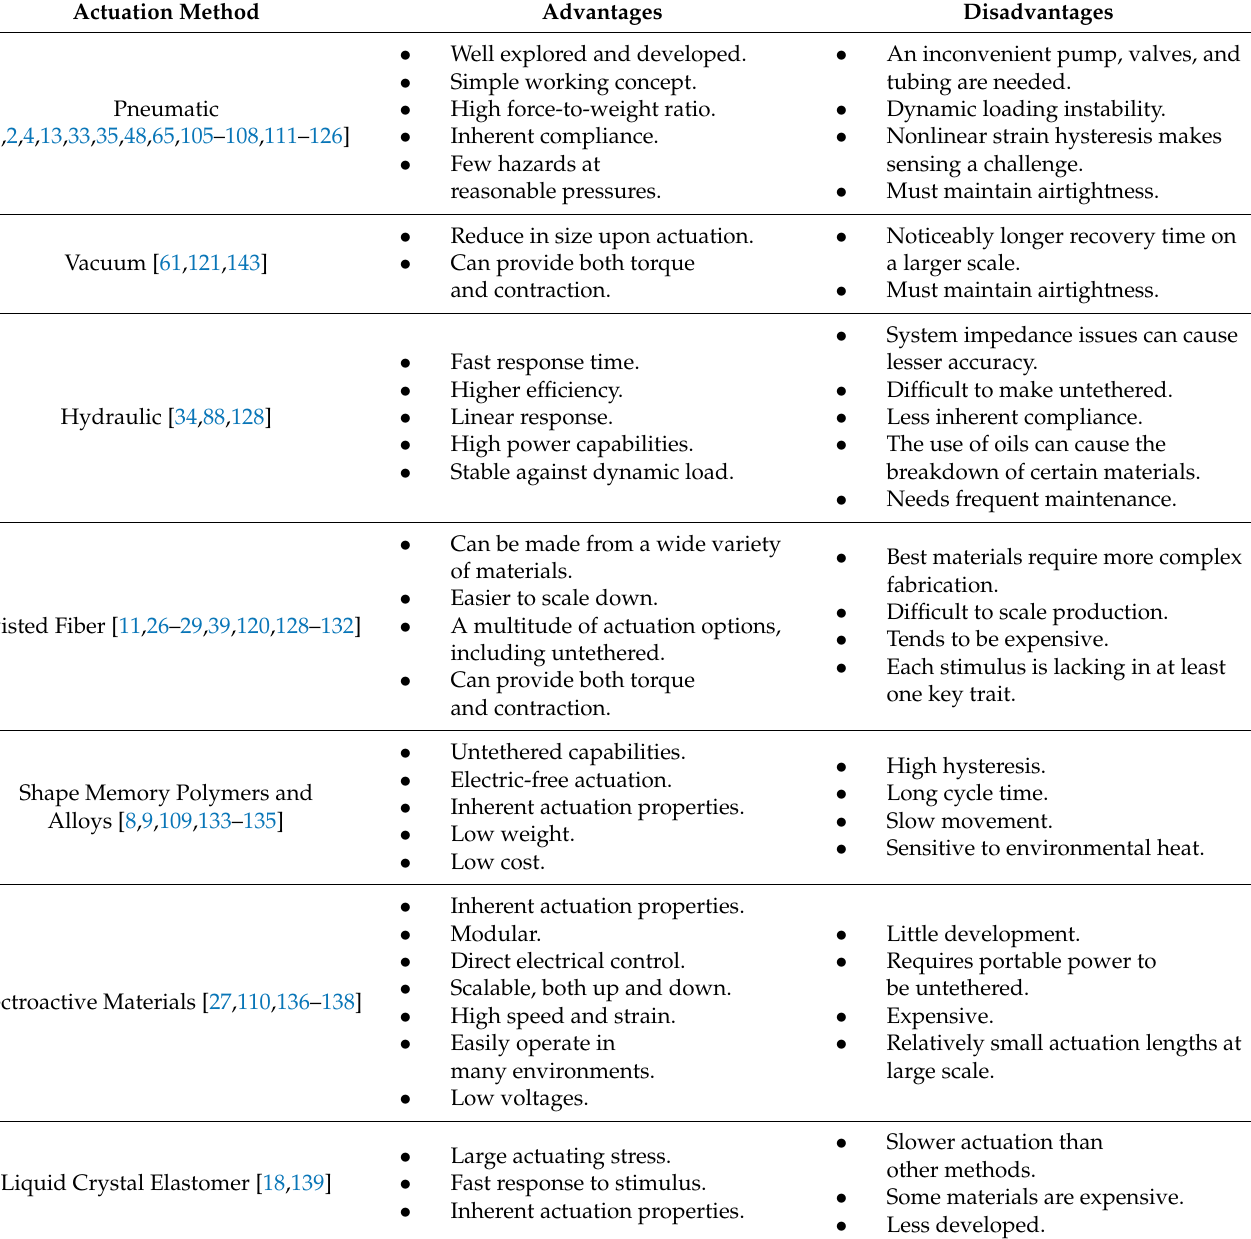
Table 4. Summary of each actuation category’s advantages and